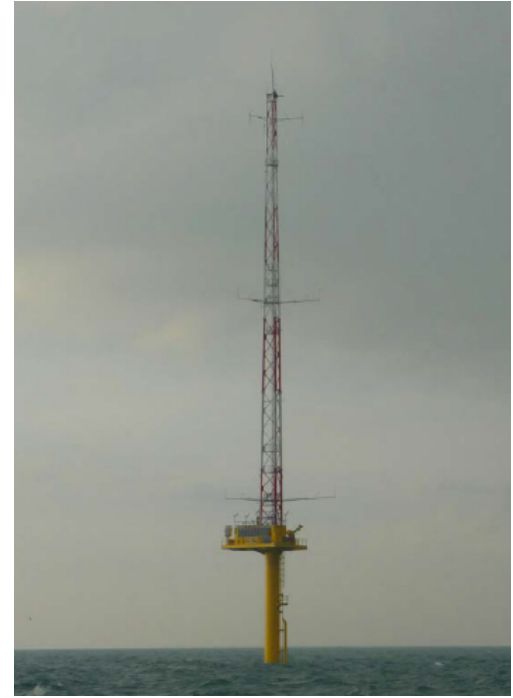
Figure 2. Meteomast IJmuiden.